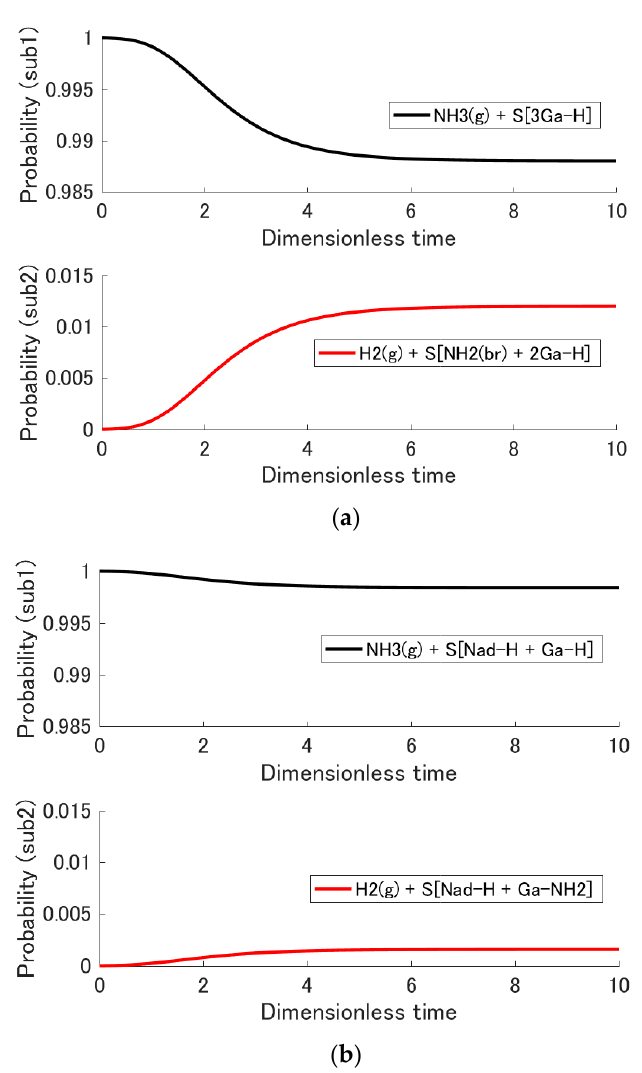
Figure 3. Evolution of the total probability of each subsystem as a function of the dimensionless time for the adsorption reactions on ( a ) S[3Ga-H] and ( b ) S[N ad -H + Ga-H]. This probability corresponds to the sum of the probabilities in Figure 2 over the energy eigenlevels.